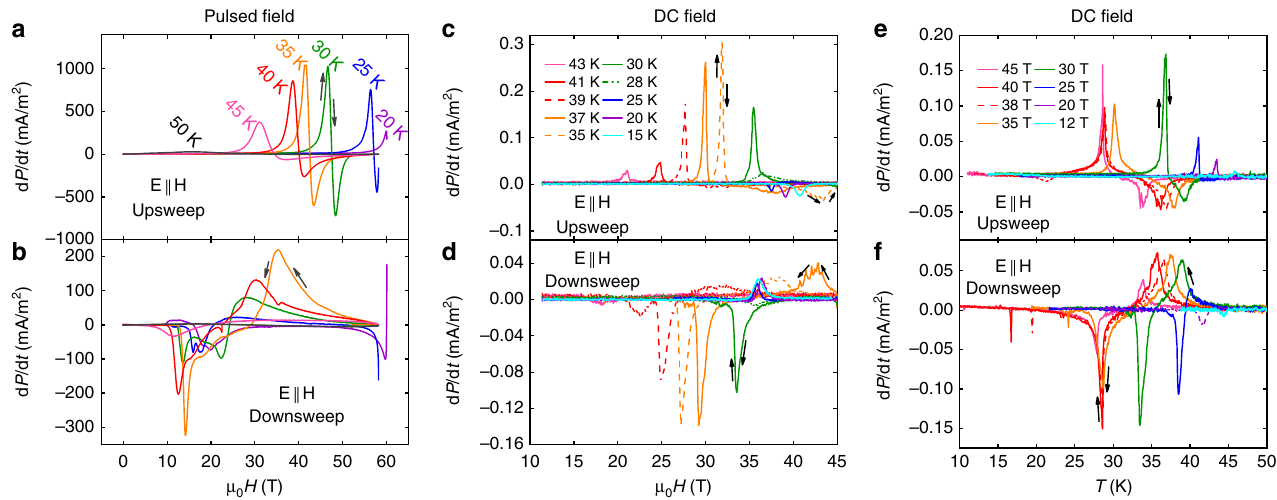
Fig. 4 Magnetic fi eld-induced electric polarization change d P /d t for E || [110] in pulsed and quasi-DC magnetic fi elds. a , b d P ( H )/d t for different T during the upsweep and downsweep of the pulsed magnetic fi eld H . c , d d P /d t measured in quasi-DC magnetic fi elds up to 45T at different T for the upsweep and downsweep. e , f d P /d t as a function of temperature in fi xed magnetic fi elds up to 45T for E || H || [ 110 ]. We see similar results for E ⊥ H , indicating no linear magnetoelectric coupling. The magnetic fi eld and temperature of the peak in d P /d t is used to generate the data points in the phase diagram of Fig. 5. The error in estimating this peak due to random noise in this data is smaller the size of the data points in Fig.